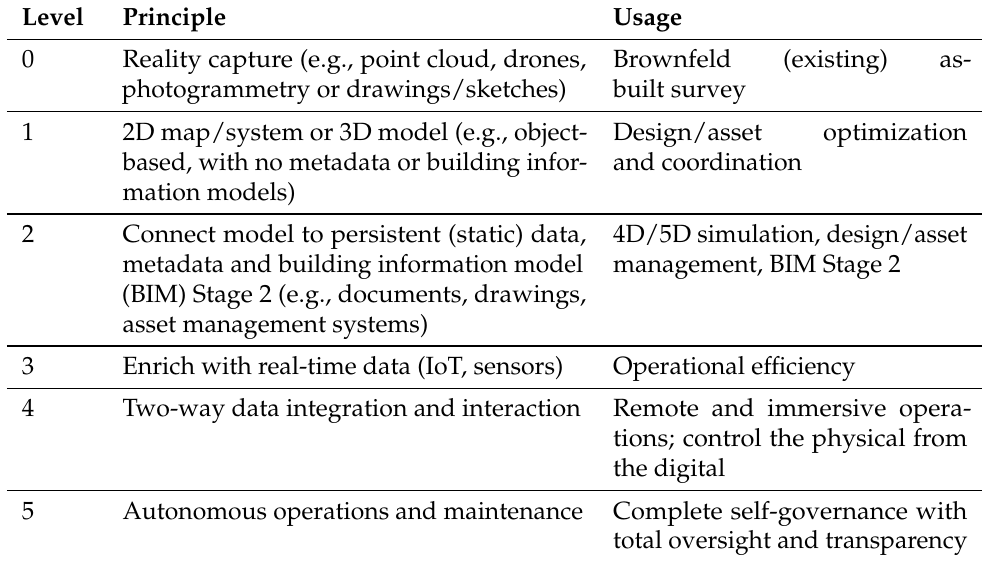
Table 1. Maturity levels for digital twins